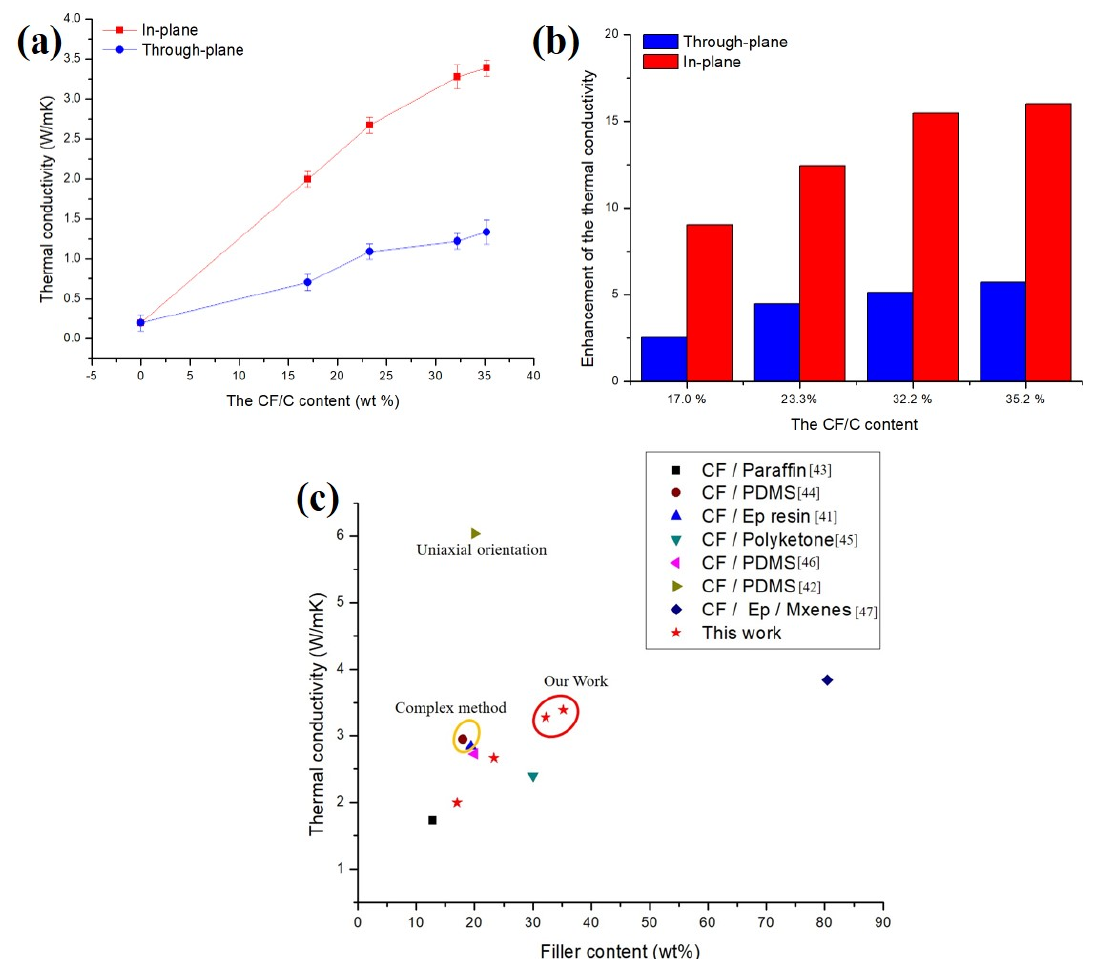
Figure 7. ( a ) The thermal conductivity of the CF/C/EP composite, ( b ) the enhancement of the thermal conductivity of the CF/C/EP composites with different CF/C contents, ( c ) the data of the thermal conductivity from previous research.